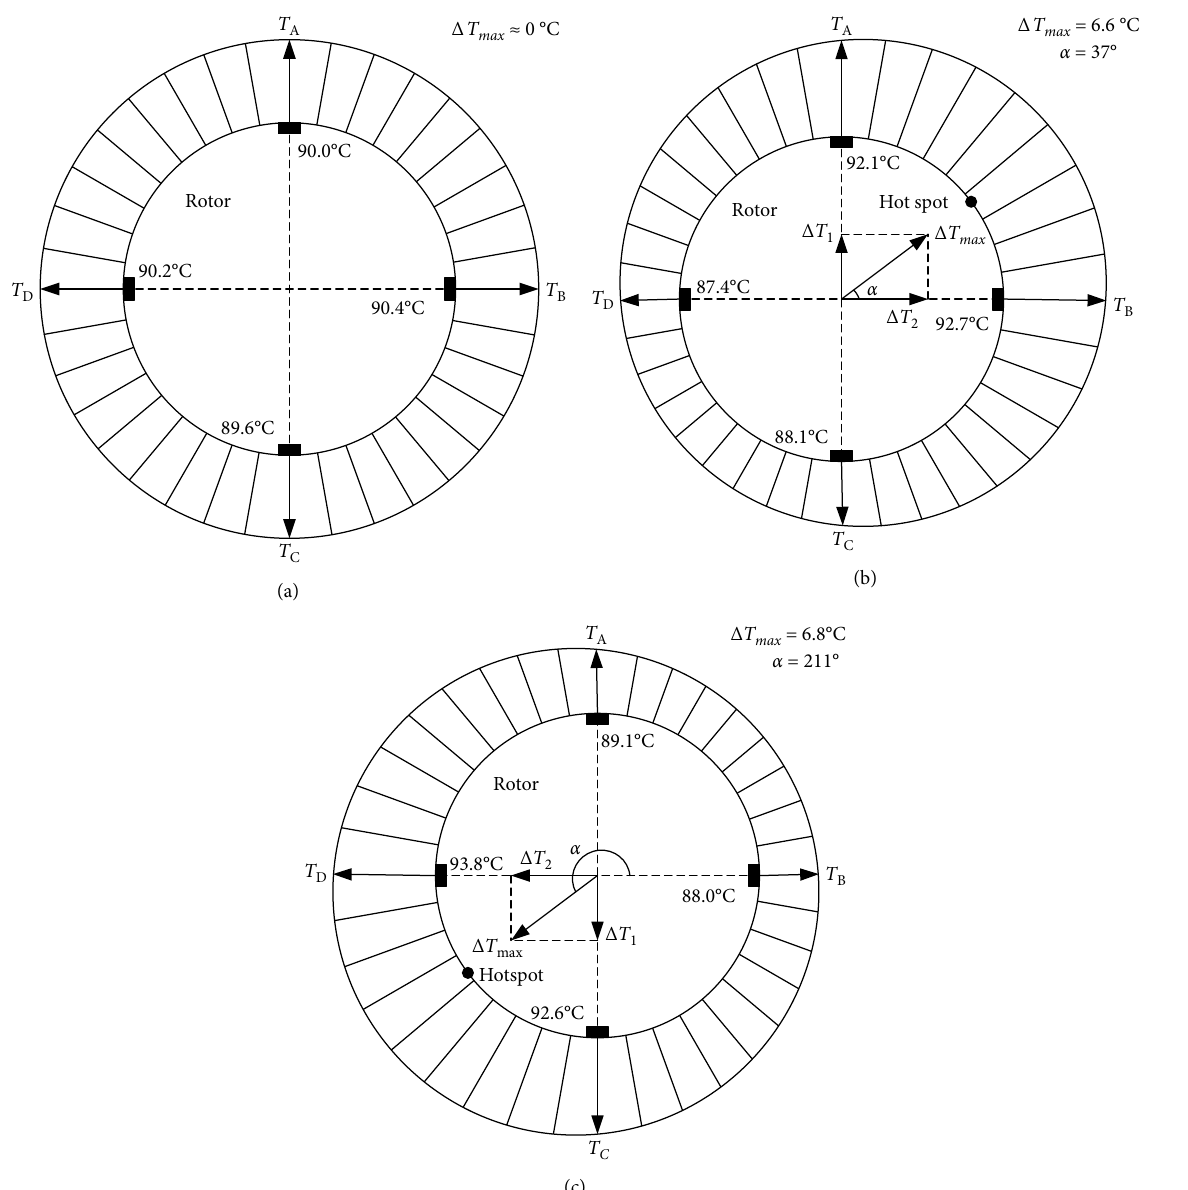
Figure 4: Journal surface temperature distribution in NDE bearing. (a) Balanced state. (b) Unbalance weight applied at 0°. (c) Unbalance weight applied at 180°.